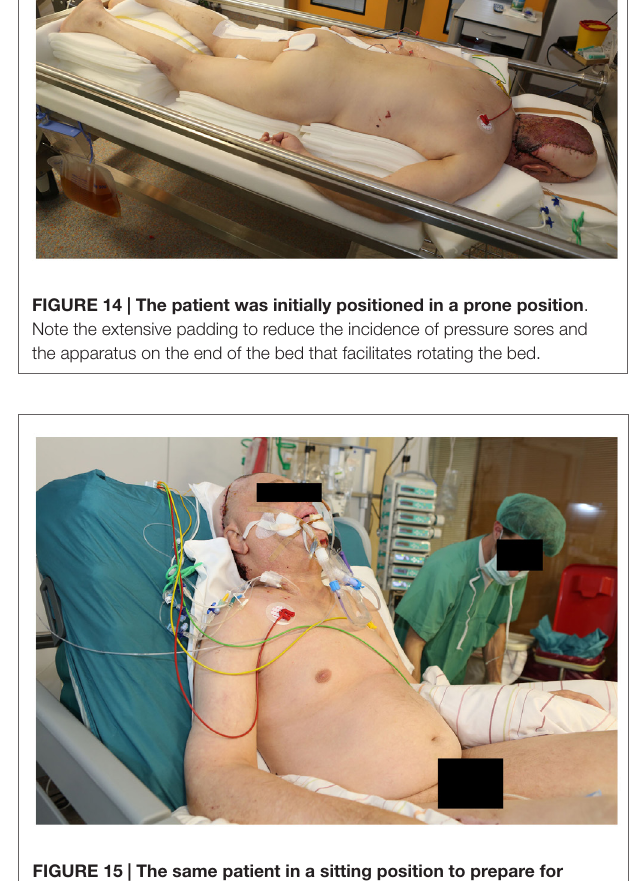
FiGURe 15 | The same patient in a sitting position to prepare for extubation